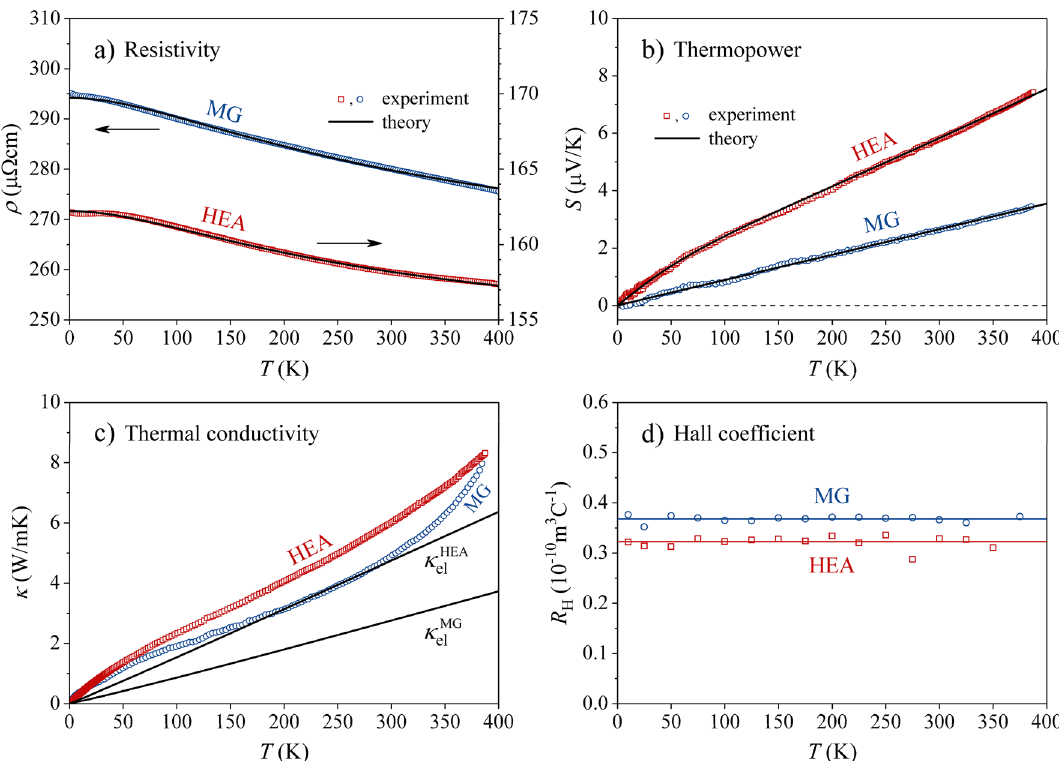
Figure 3. Transport coefficients of the Al 0.5 TiZrPdCuNi alloy in the HEA and MG states: ( a ) electrical resistivity, ( b ) thermopower, ( c ) thermal conductivity, and ( d ) Hall coefficient. Solid curves in the panels ( a ) and ( b ) are fits obtained with the spectral conductivity model, described in the text. In panel ( c ), the experimental data represent the total thermal conductivities κ HEA and κ MG , whereas the solid curves are the calculated electronic thermal conductivities κ HEA el and κ MG el .